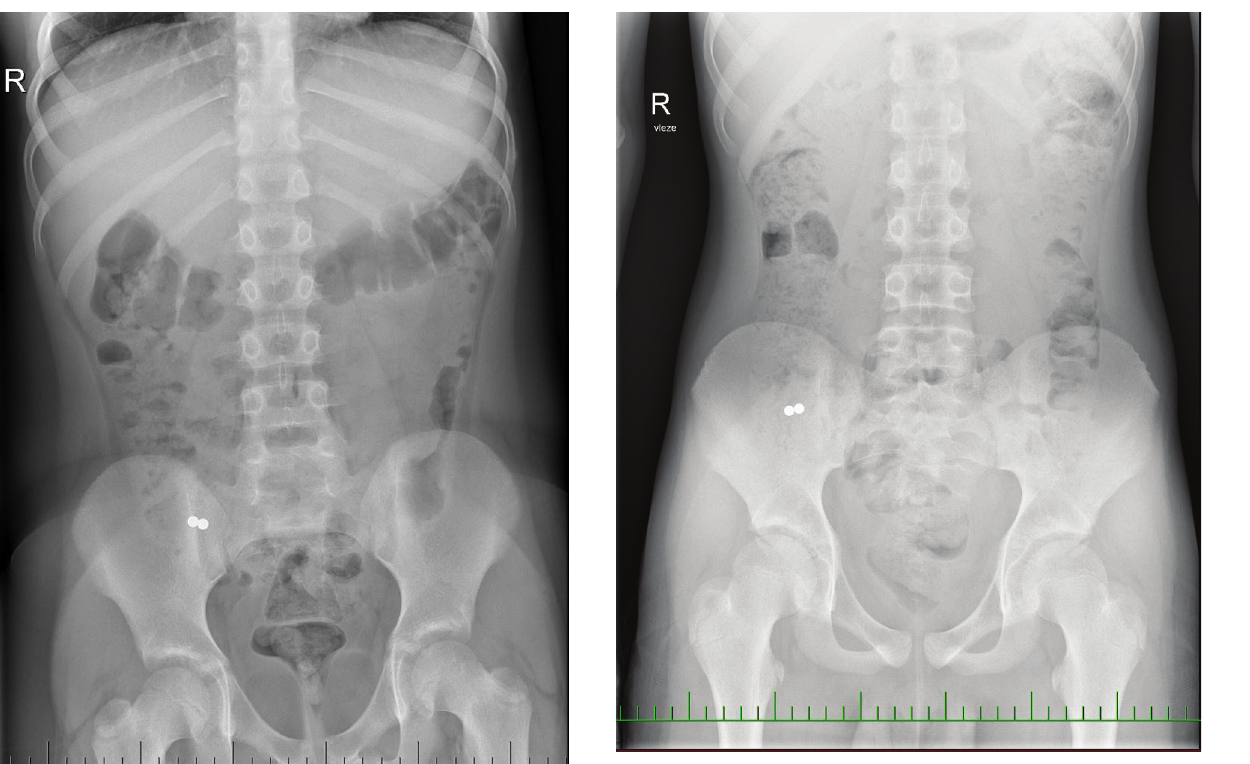
Fig. 2 Abdominal X-rays contrasting oval MFBs in the right hypo- gastrium. MFBs, magnetic foreign